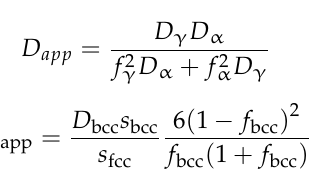
Fig.13, 50 o C [56] Uranus B50, 22 o C [1] 301, 25 o C